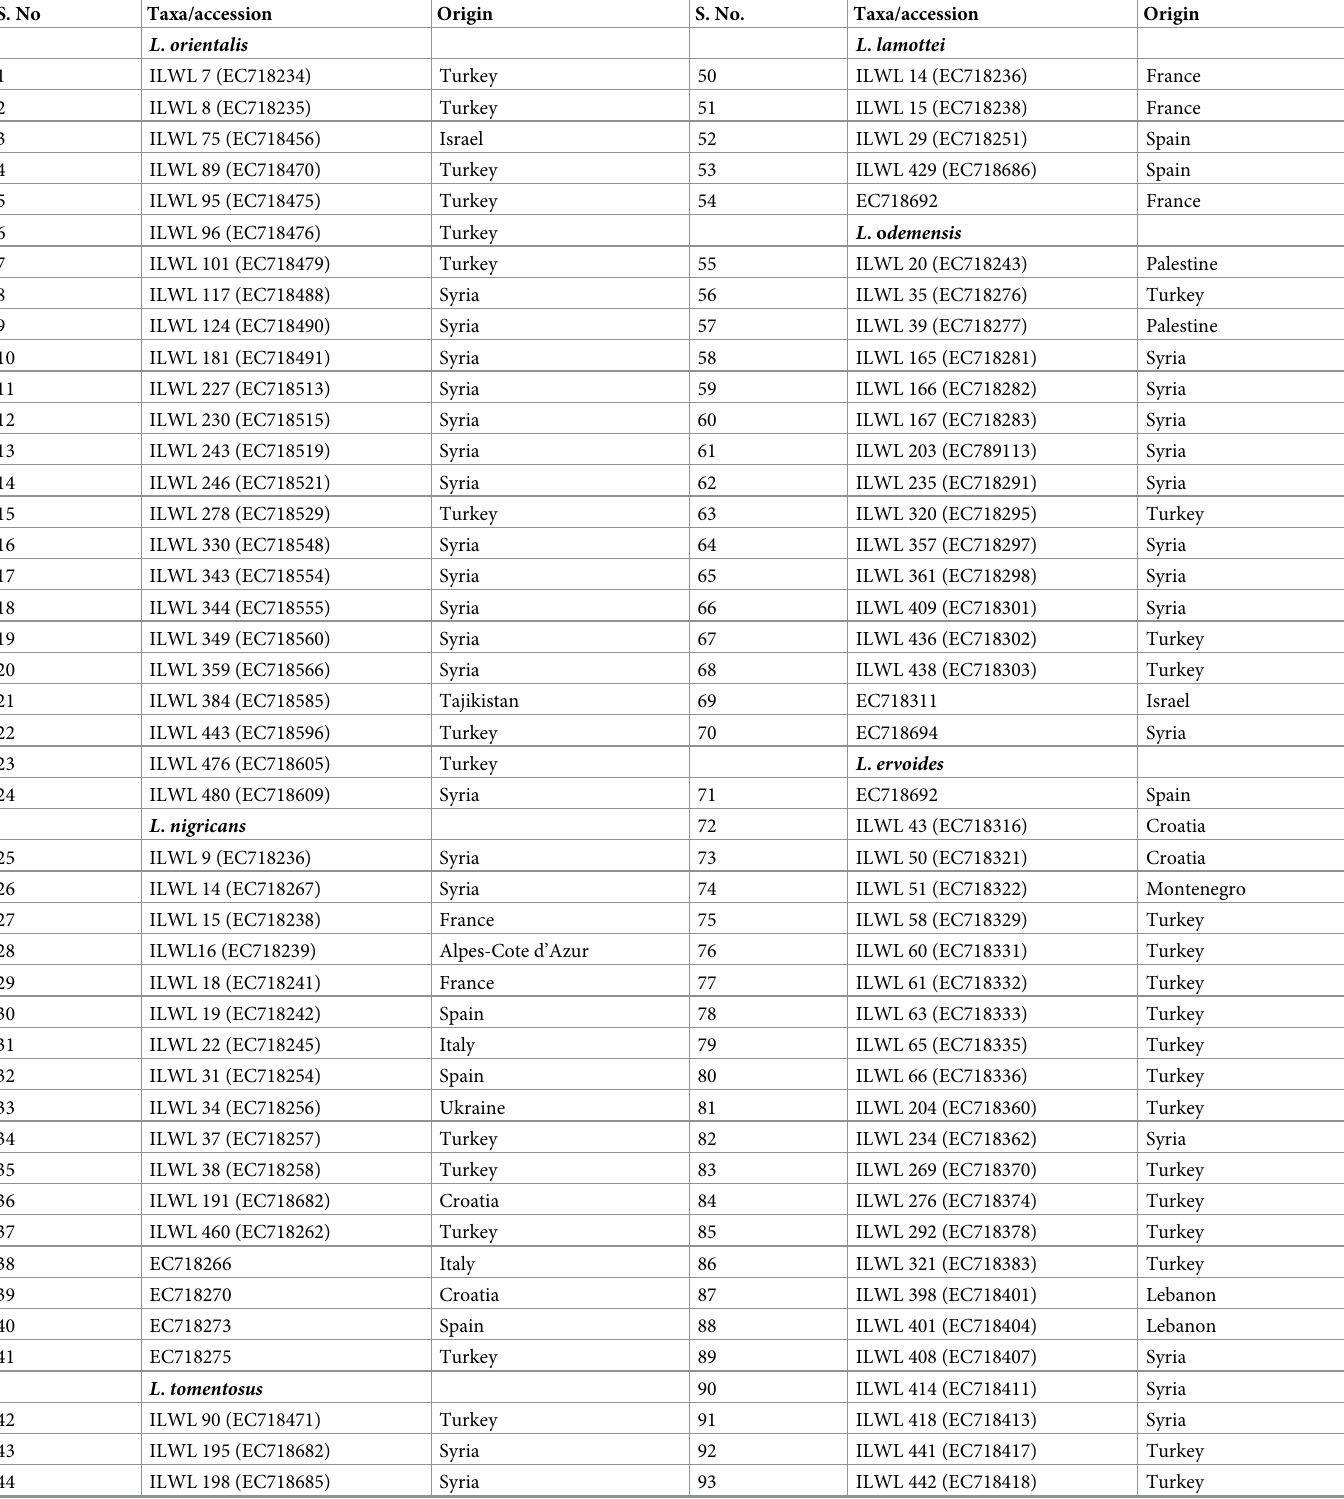
Table 1. List of taxa wise wild lentil accessions along with their country of